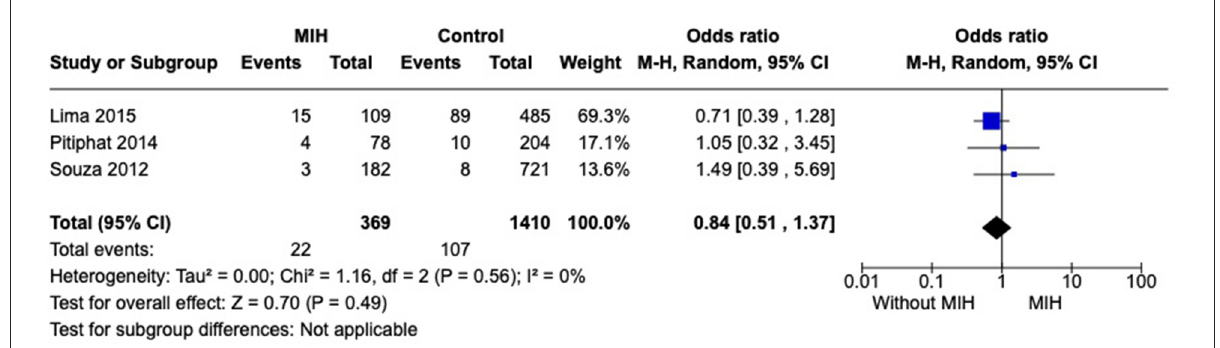
FIGURE3 Forest plot of meta-analysis for the prevalence of pneumonia among subjects with MIH. CI, confidence interval.